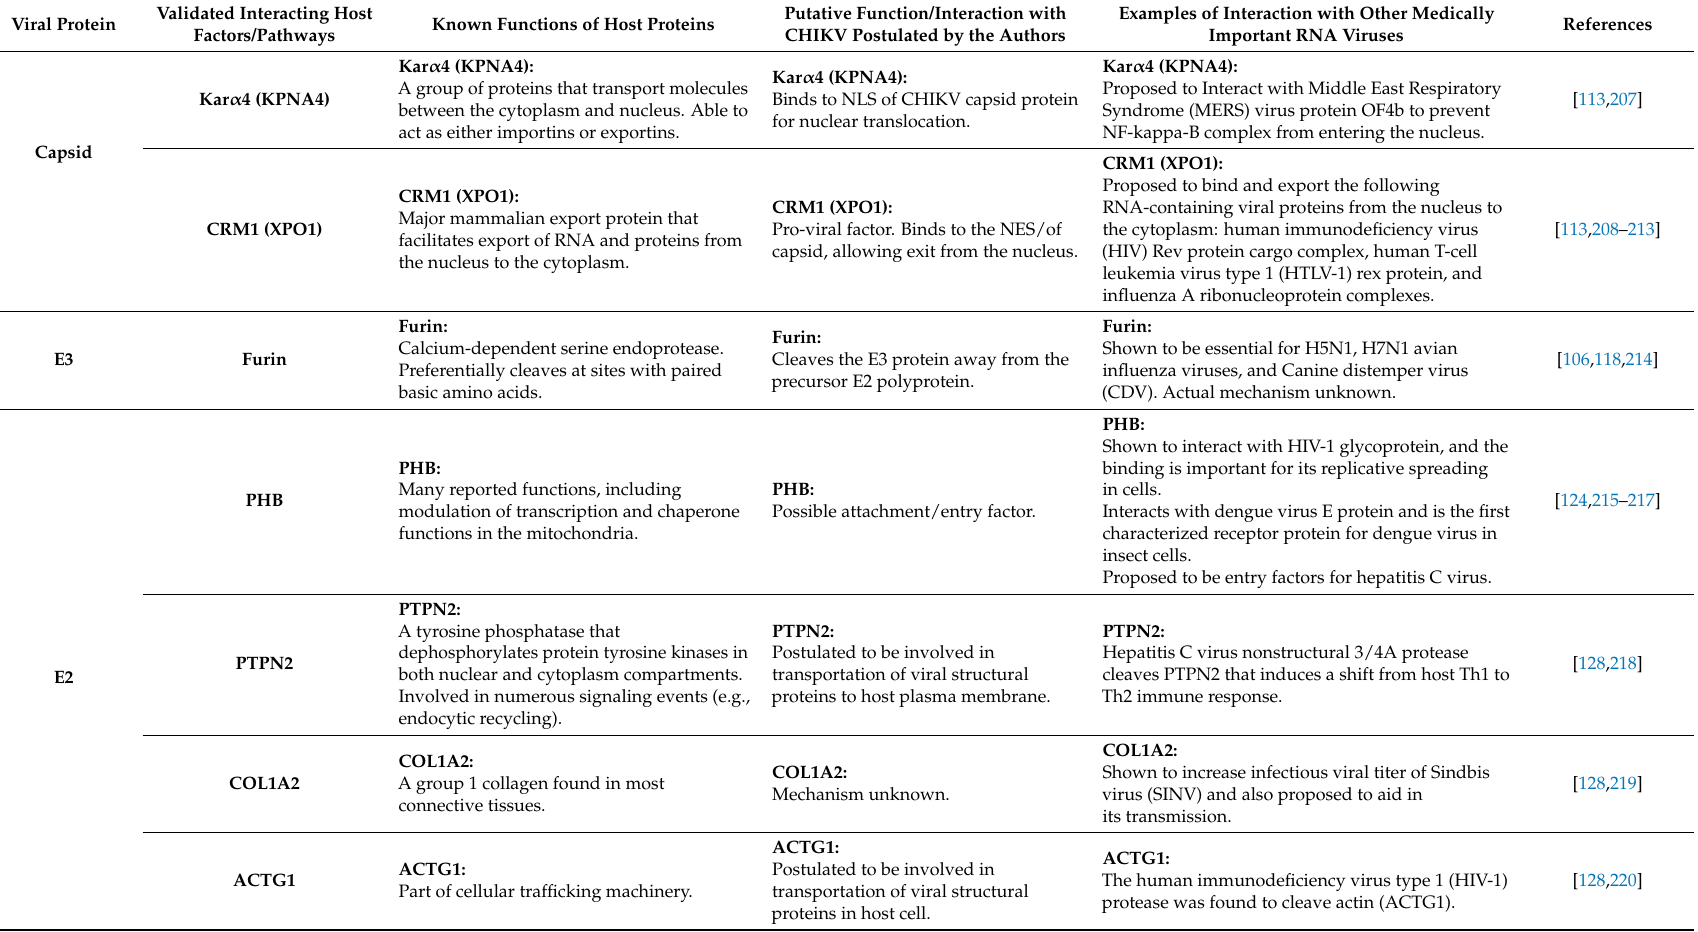
Table 1. Summary of host factors known to interact with CHIKV